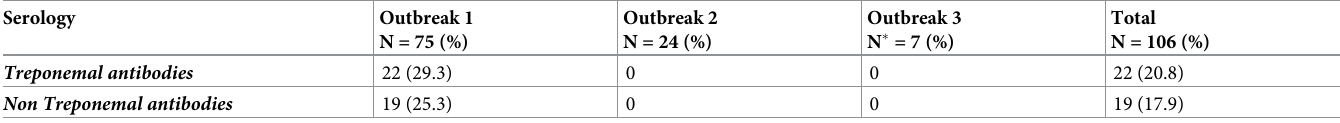
Table 3. Presence of treponemal and non-treponemal antibodies in serum samples collected in the context of the three outbreaks. Serology